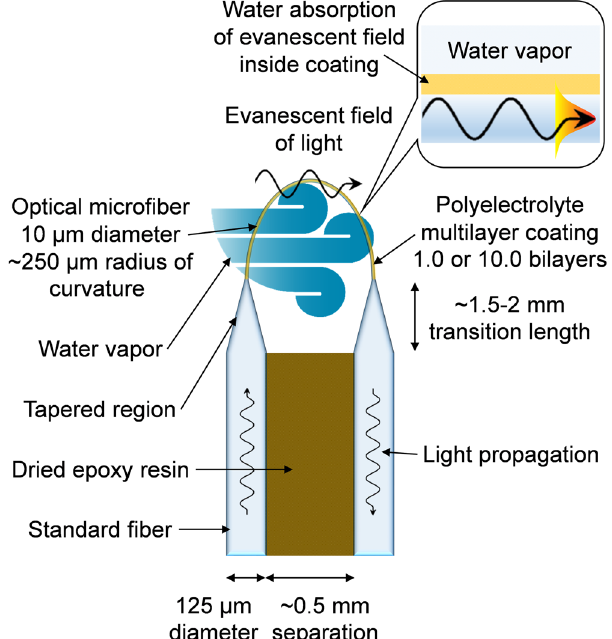
Figure 1. Schematic of the sensor head. Inset: side-view structure of sensor head with the optical microfiber at the bottom and external environment at the